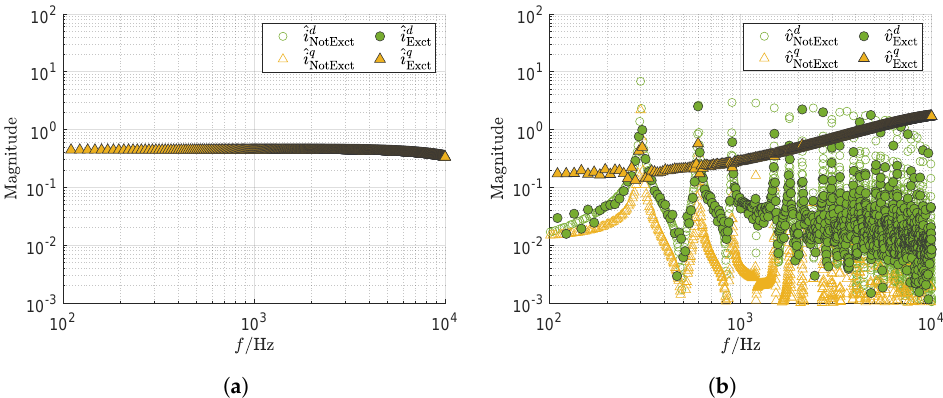
Figure 16. Measurement of the realistic impedance scenario during excitation of the q -axis. ( a ) Spec- trum of the current i meas in the dq domain. ( b ) Spectrum of the voltage v meas in the dq